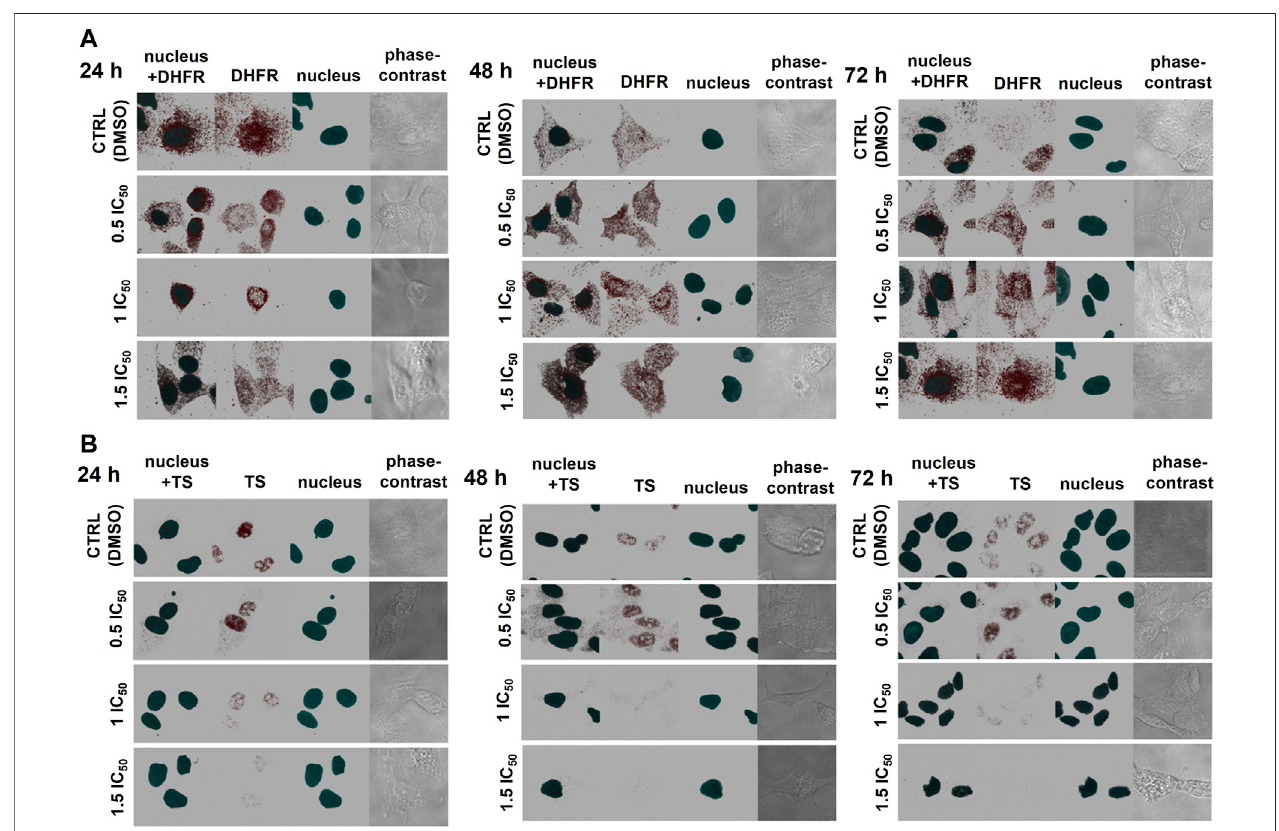
FIGURE4| TheeffectofCX-4945onthelocalizationandproteinlevelsofDHFRandTSinA-549cells.ThecellsweretreatedwithCX-4945usedinconcentrations corresponding to 0.5 IC 50 , 1 IC 50 , and 1.5 IC 50 , fi xed after incubation for 24, 48, and 72 h; after blocking, they were probed with the primary anti-DHFR (A) or anti-TS antibodies (B) . Subsequently, the cells were treated with Alexa Fluor 555-conjugated secondary antibody (red fl uorescence) and Hoechst 33342 (nuclei, blue fl uorescence).Thepresentedpictures ofDHFR, TS,nucleus, and combined are3Dpictures ofat least15z-stack photos visualized togethertoshow thefullthree- dimensionaldistributionoftheexaminedproteins.Thepicturesinthefourthcolumnofeachpanelare2Dphasecontrastphotographs.Eachpictureisshotwiththesame zoom settings. Photographs represent 65 × 65 µm